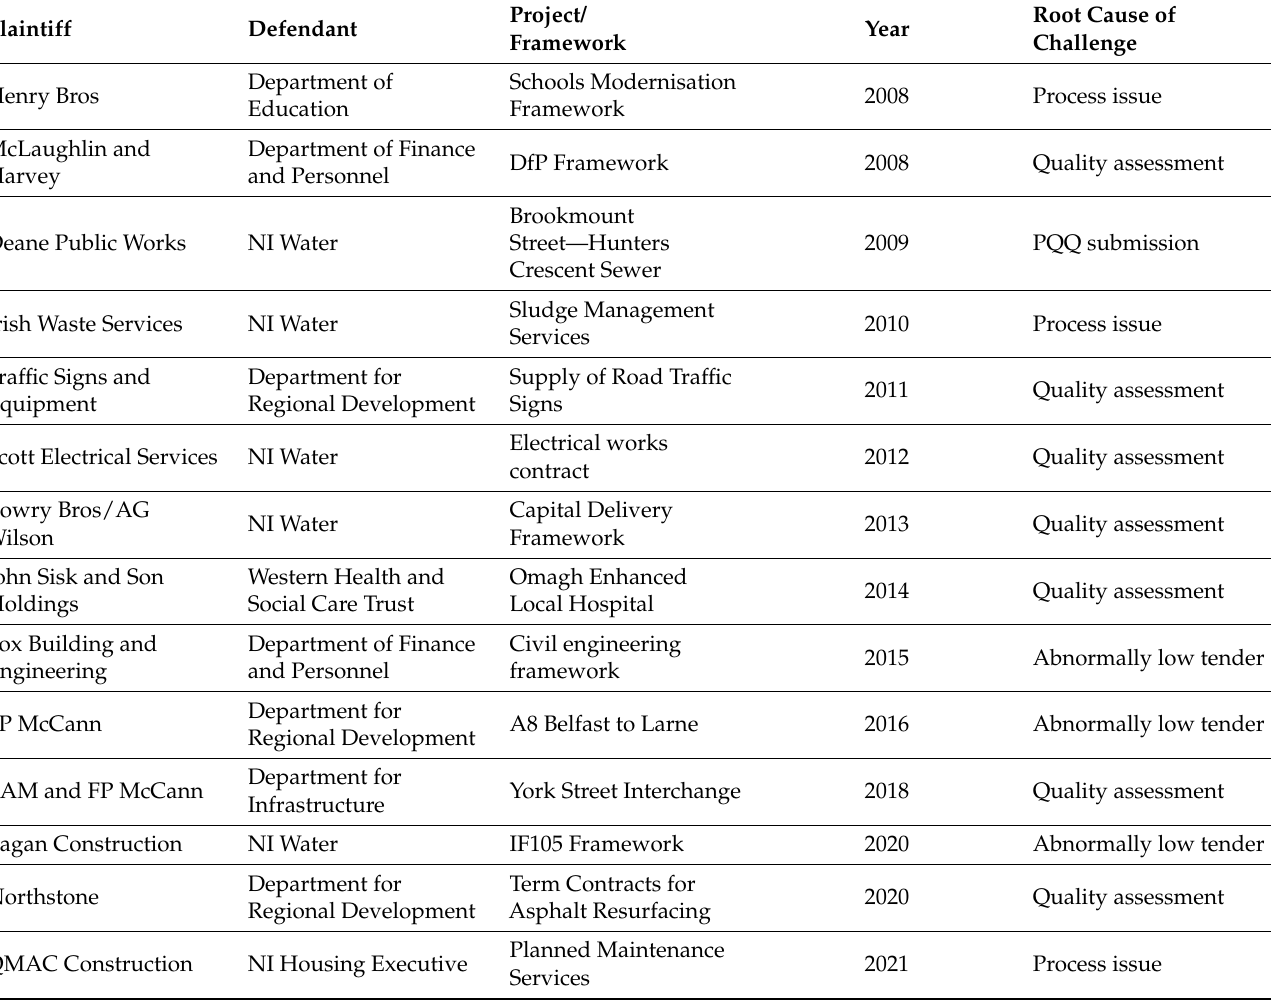
Table 1. Summary of public procurement court judgements in NI (Judiciary NI,